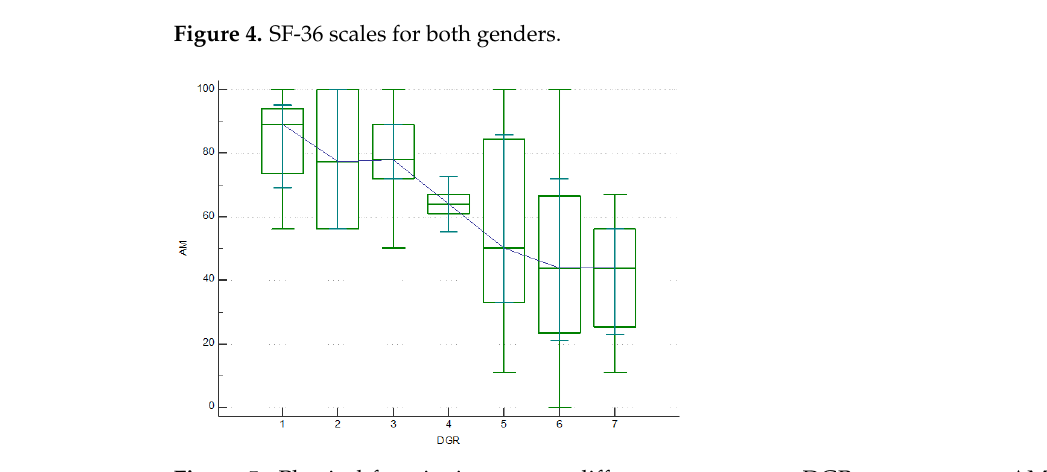
Figure 5. Physical functioning among different age groups. DGR—age groups. AM—physical functioning.